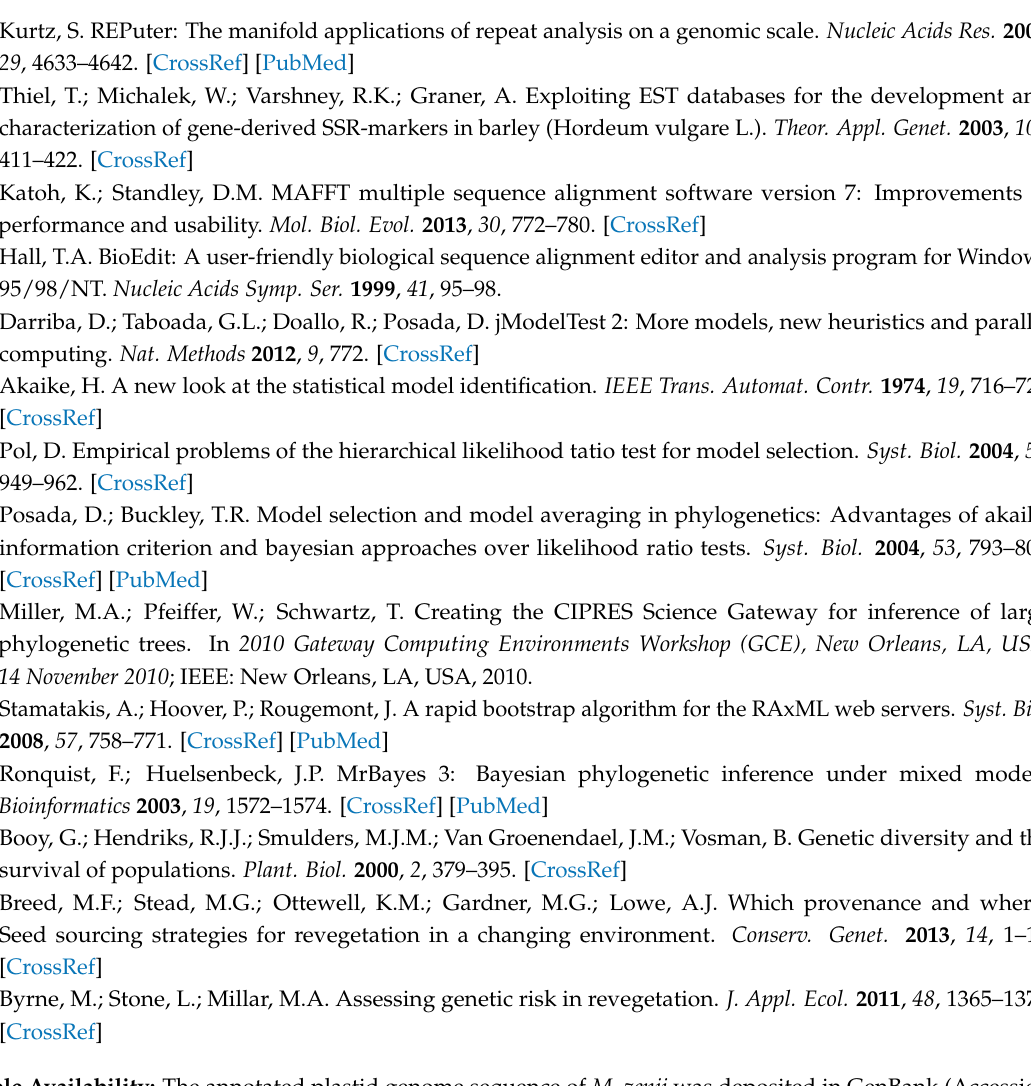
Sample Availability: The annotated plastid genome sequence of M. zenii was deposited in GenBank (Accession number MH607378). Samples of the compounds are available from the